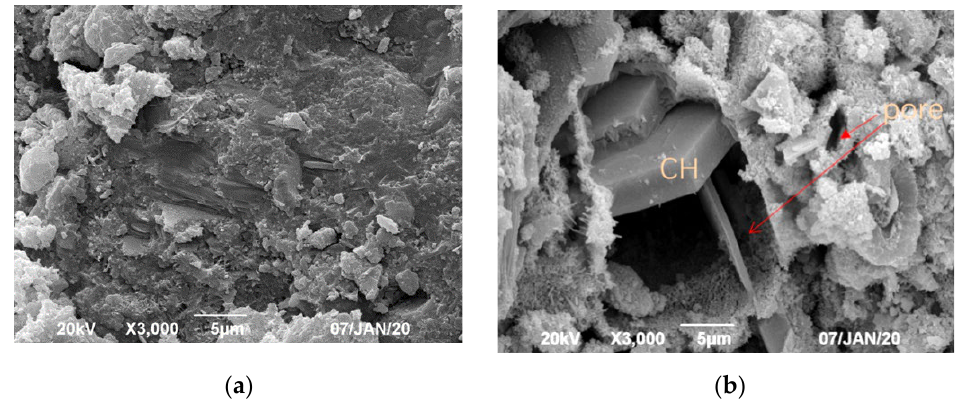
Figure 6. Microstructure of FA0-P under different curing systems, ( a ) SC and ( b ) HD.